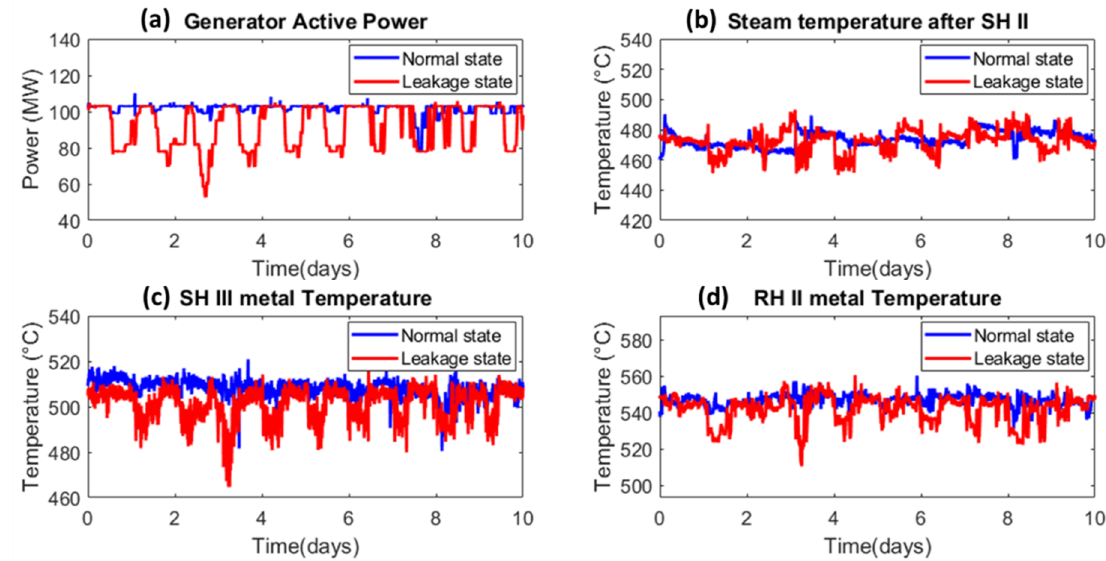
Figure 6. Effect of tube leakage on leak-sensitive variables ( a ) Generator active Power ( b ) Steam temperature after SH II ( c ) SH III metal temperature ( d ) RH II metal temperature.